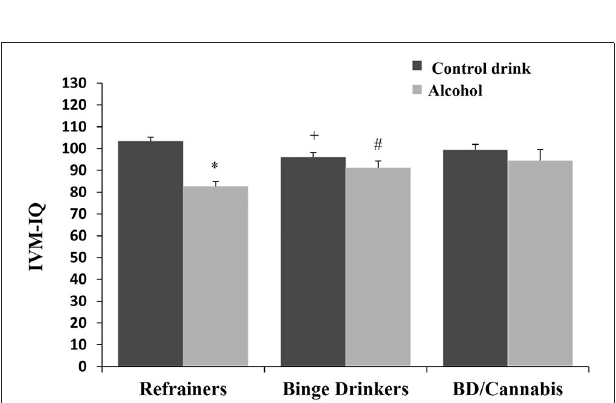
FIGURE 2 | Performance in scenes memory task (mean + SEM) in women. * p < 0.05 vs. Control drink. + p < 0.05 vs. Refrainers-Control drink (R-Co). # p < 0.05 vs. Refrainers-Alcohol (R-A).